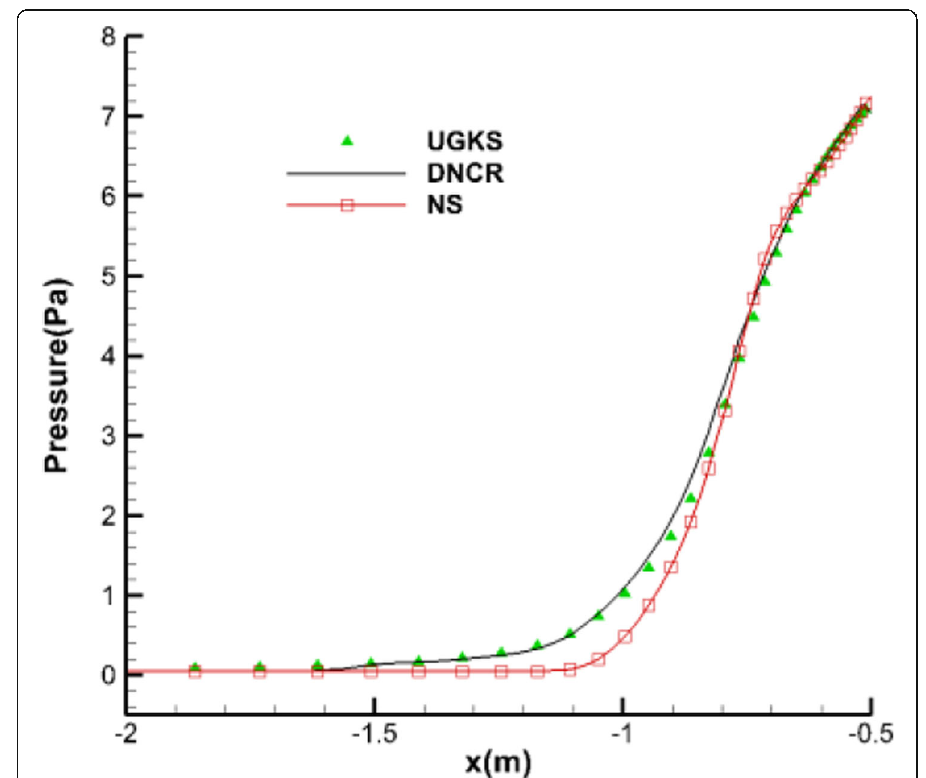
Fig. 11 Pressure distribution along the stagnation